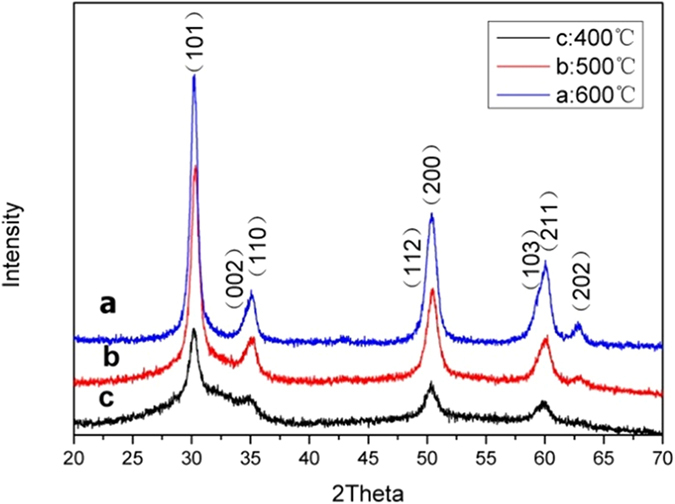
XRD patterns of ZrO2 NPs synthesized at different temperatures.